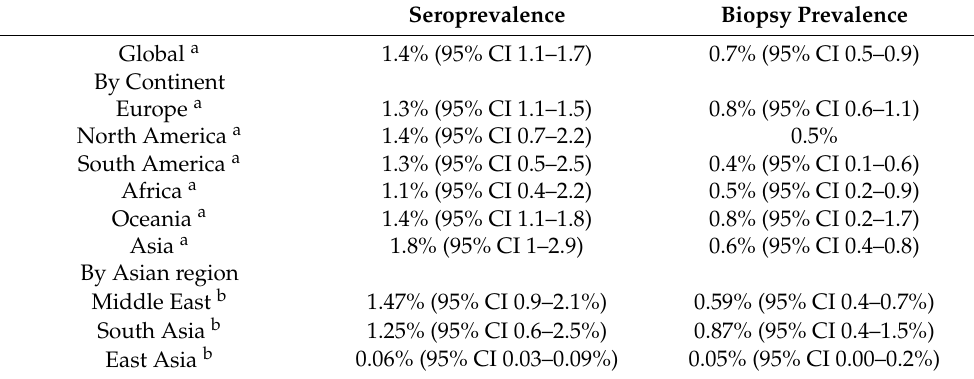
Table 2. Global prevalence of celiac disease with a focus on